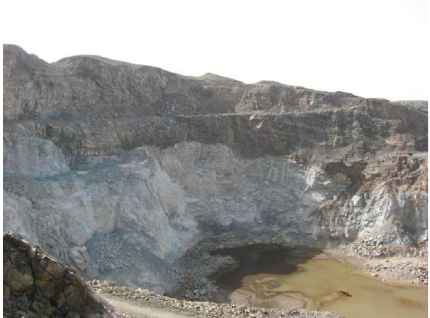
Figure 1: Open-pit mining area.